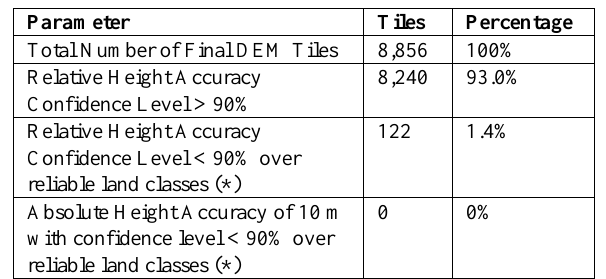
Table 3. Height accuracy statistics of final DEM products with status of February 2015. (*)Tiles with unreliable data, e.g. over forest or sea ice, are filtered out in the accuracy calculations.